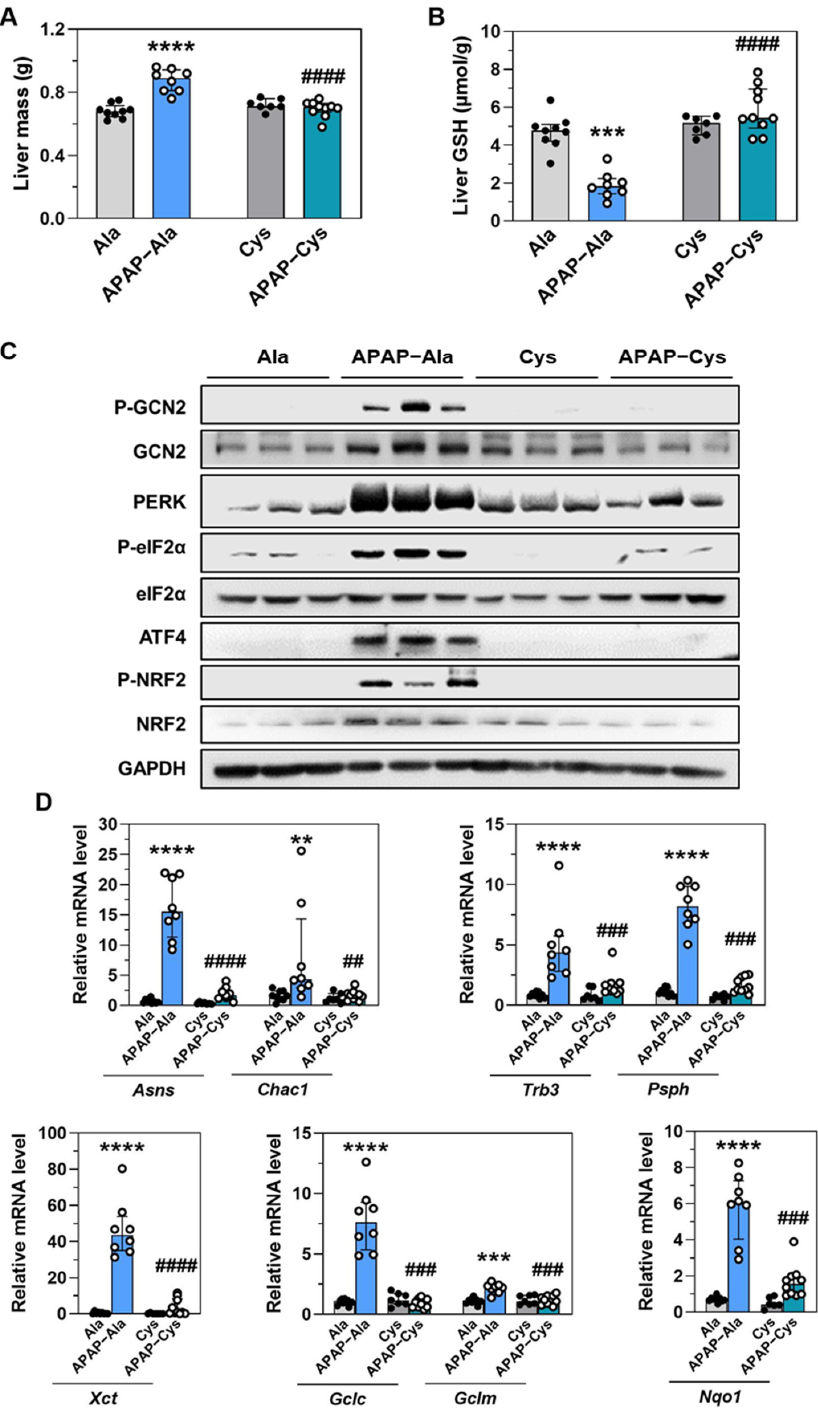
Figure 7. Effect of dietary supplementation with Cys on the liver response to treatment with APAP for 18 d. Ctrl and APAP diets were supplemented with alanine (Ala) or cysteine (Cys). Ala was added to make diets iso-nitrogenous to Cys diets. The APAP-Cys group was fed ad libitum. The three other groups were pair-fed with the APAP-Cys group. ( A ) Liver mass. ( B ) Total GSH concentration in the liver. ( C ) Immunoblot analysis of phosphorylation (P-) of GCN2, eIF2 α , and NRF2, GCN2, PERK, eIF2 α , ATF4, NRF2, and GAPDH. ( D ) Expression of a set of ATF4-dependent genes. Total RNA extracted from the liver was analyzed by reverse transcription RT-qPCR. Each bar shows the median with interquartile and dots are individual values. ** p ≤ 0.01; *** p ≤ 0.001 **** p ≤ 0.0001 vs. PF-Ala; ## p ≤ 0.01; ### p ≤ 0.001; #### p ≤ 0.0001 vs. respective Ala group; Mann Whitney